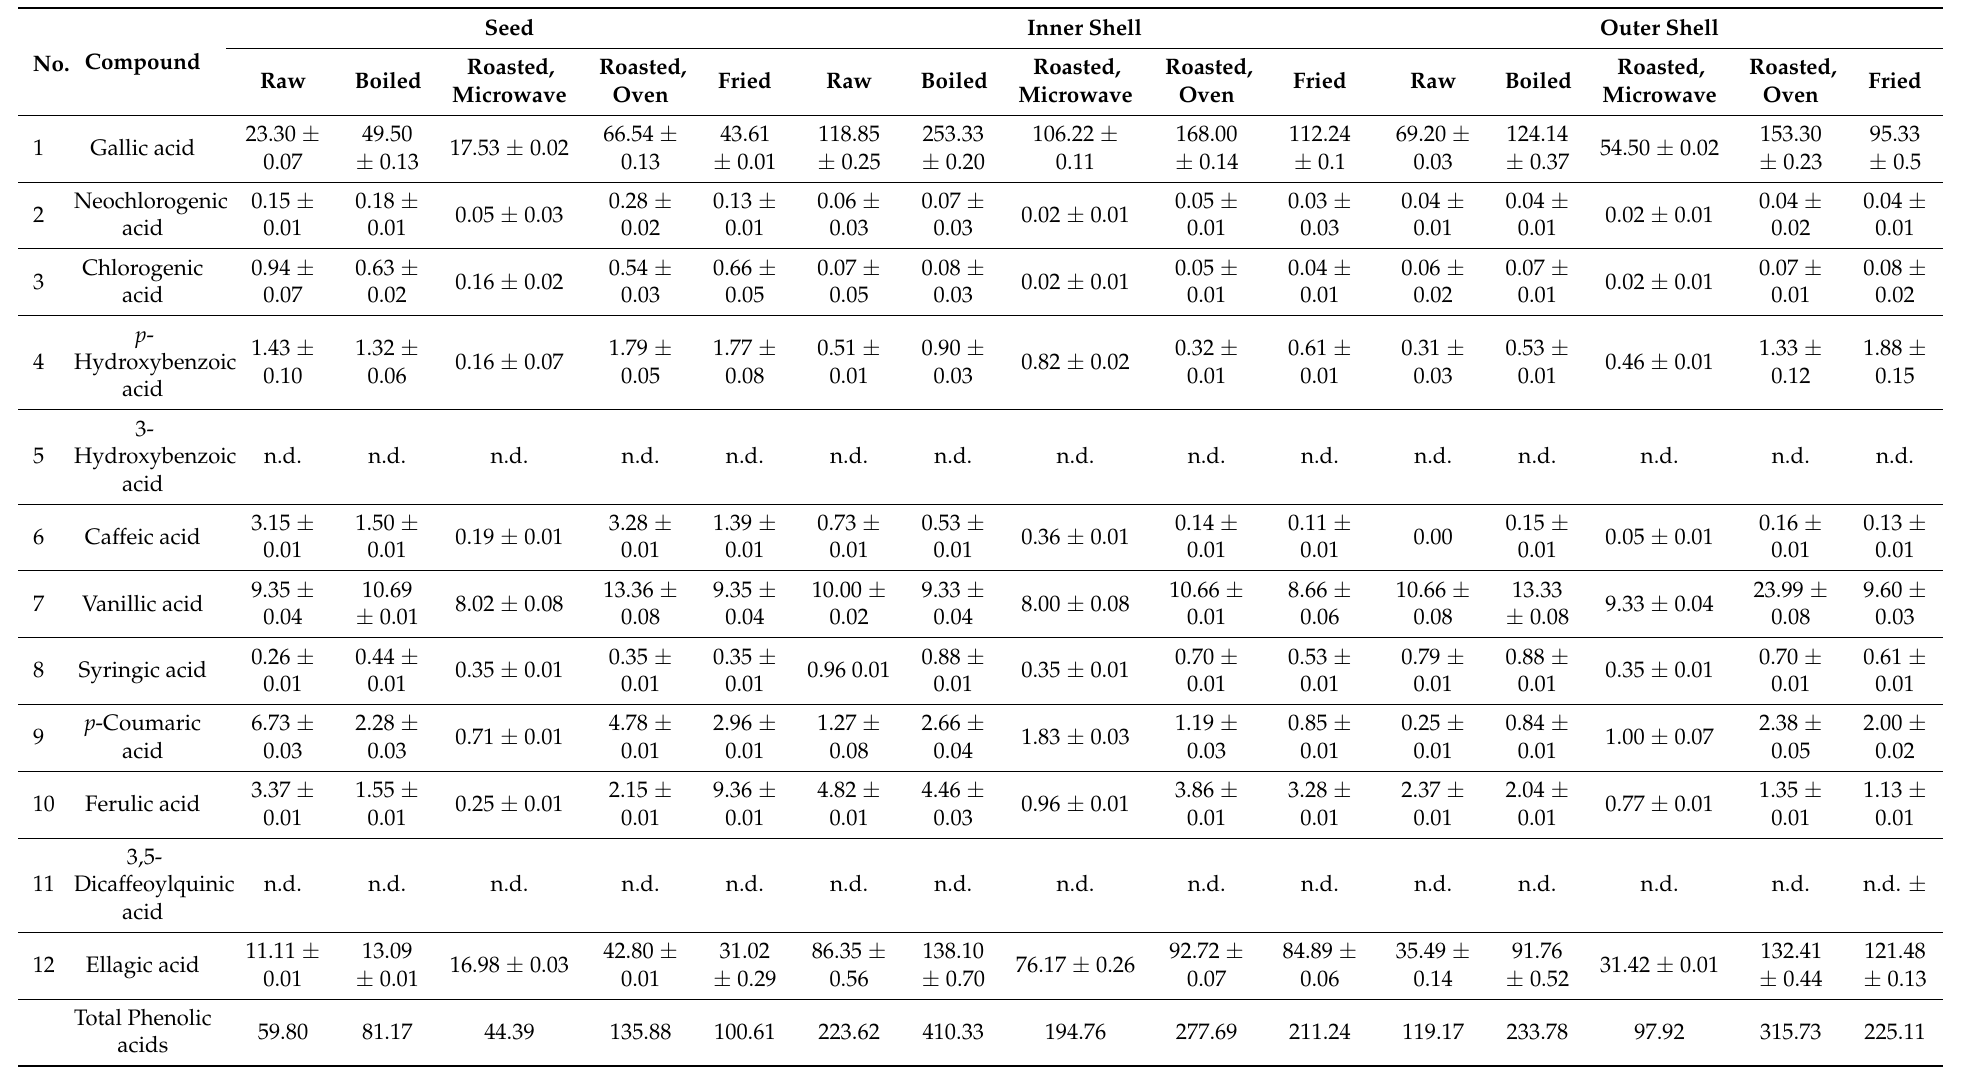
Table 2. Contents of the bioactive phenolics (mg/kg dry weight) determined by HPLC-MS/MS in chestnut seeds and shells. Seed Inner Shell Outer Shell Roasted, Roasted, Roasted, Roasted, Fried Raw Boiled Fried Raw Boiled Microwave Oven